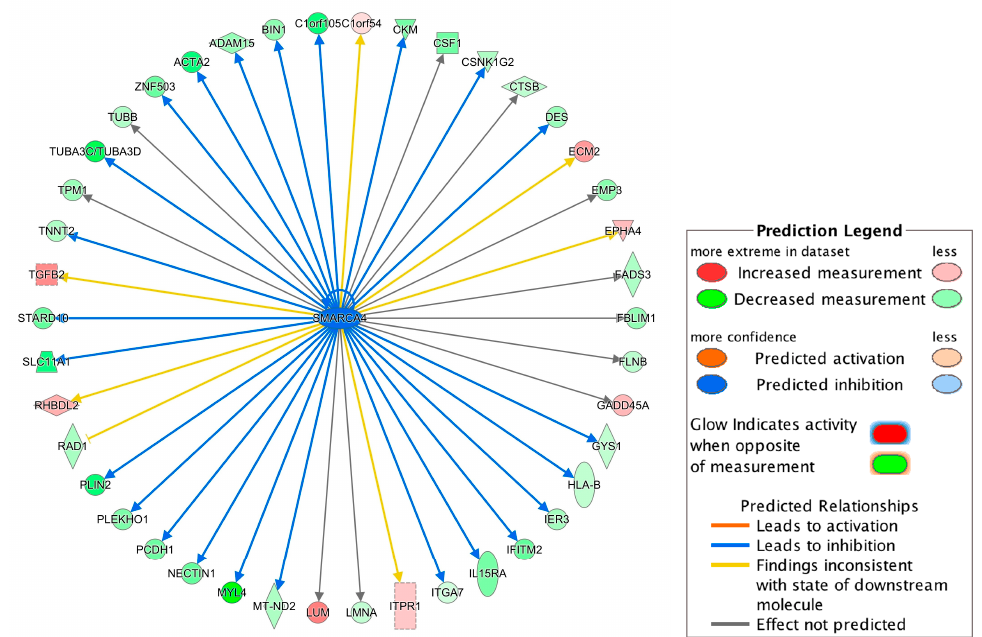
Figure 4. Network of the upstream regulator SMARCA4 and its targeted genes. The network was constructed using the differentially expressed genes identified in our meta-analysis. For example, the downregulation of SMARCA4 led to the inhibition (indicated by the blue arrow line) of the DES expression and the downregulation of DES is indicated by the green color. Other indicators are explained in the Prediction Legend section.